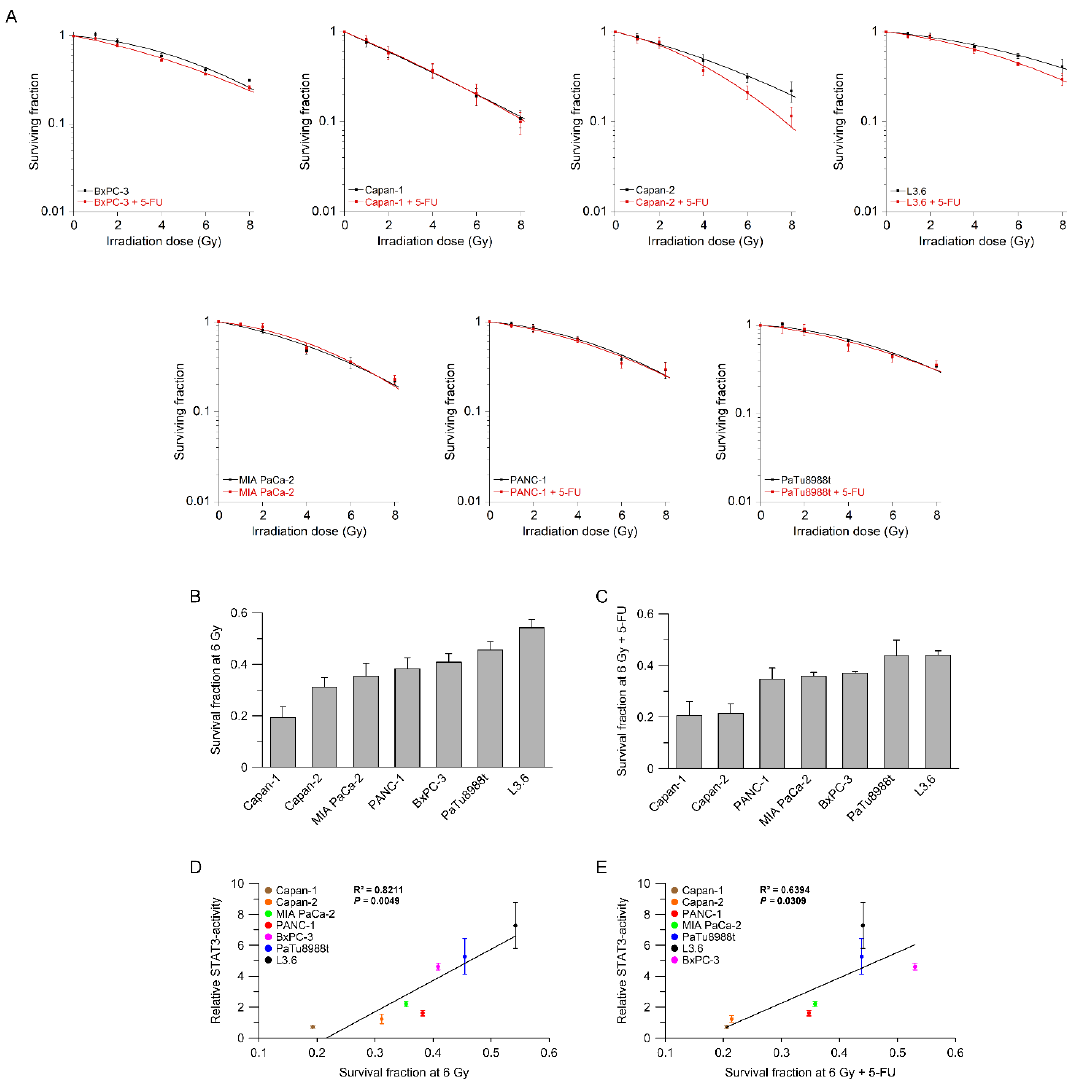
Figure 2. Transcriptional activity of IL-6/STAT3 signaling correlates with sensitivity of pancreatic adenocarcinoma cell lines to (chemo)radiotherapy. ( A ) Cell lines were assessed by colony formation assays (CFAs) to measure their survival following irradiation (RT, black lines), or irradiation in the presence of 5-FU (CRT, red lines); ( B ) comparison of survival fraction at 6 Gy (SF6) after irradiation alone or ( C ) 5-FU-based chemoradiotherapy; ( D , E ) SF6 (RT, D ; CRT, E ) correlated with STAT3 transcriptional activity. Data are presented as mean ± s.e.m. from at least n = 3 independent biological replicates. Pearson’s correlation.